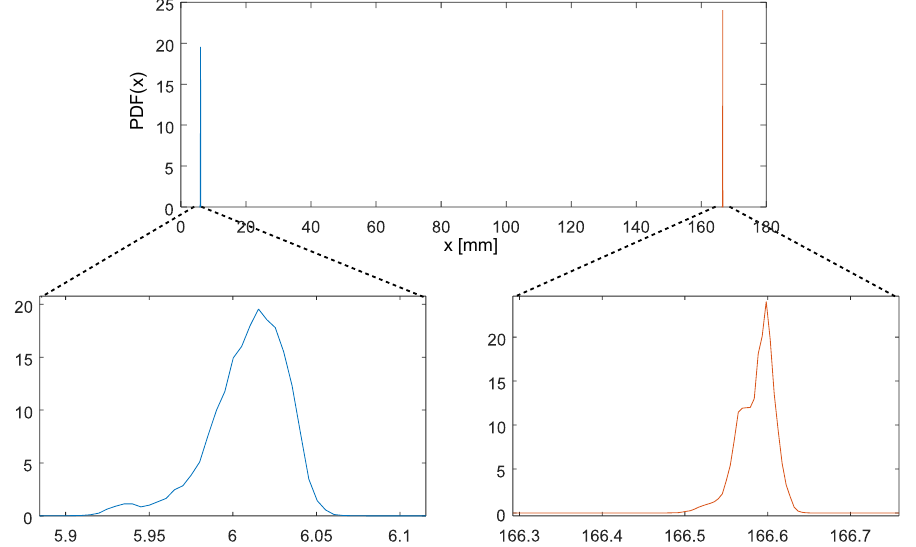
Figure 9. PDF kernel estimation of location for M 1 and M 2 using Vicon T40